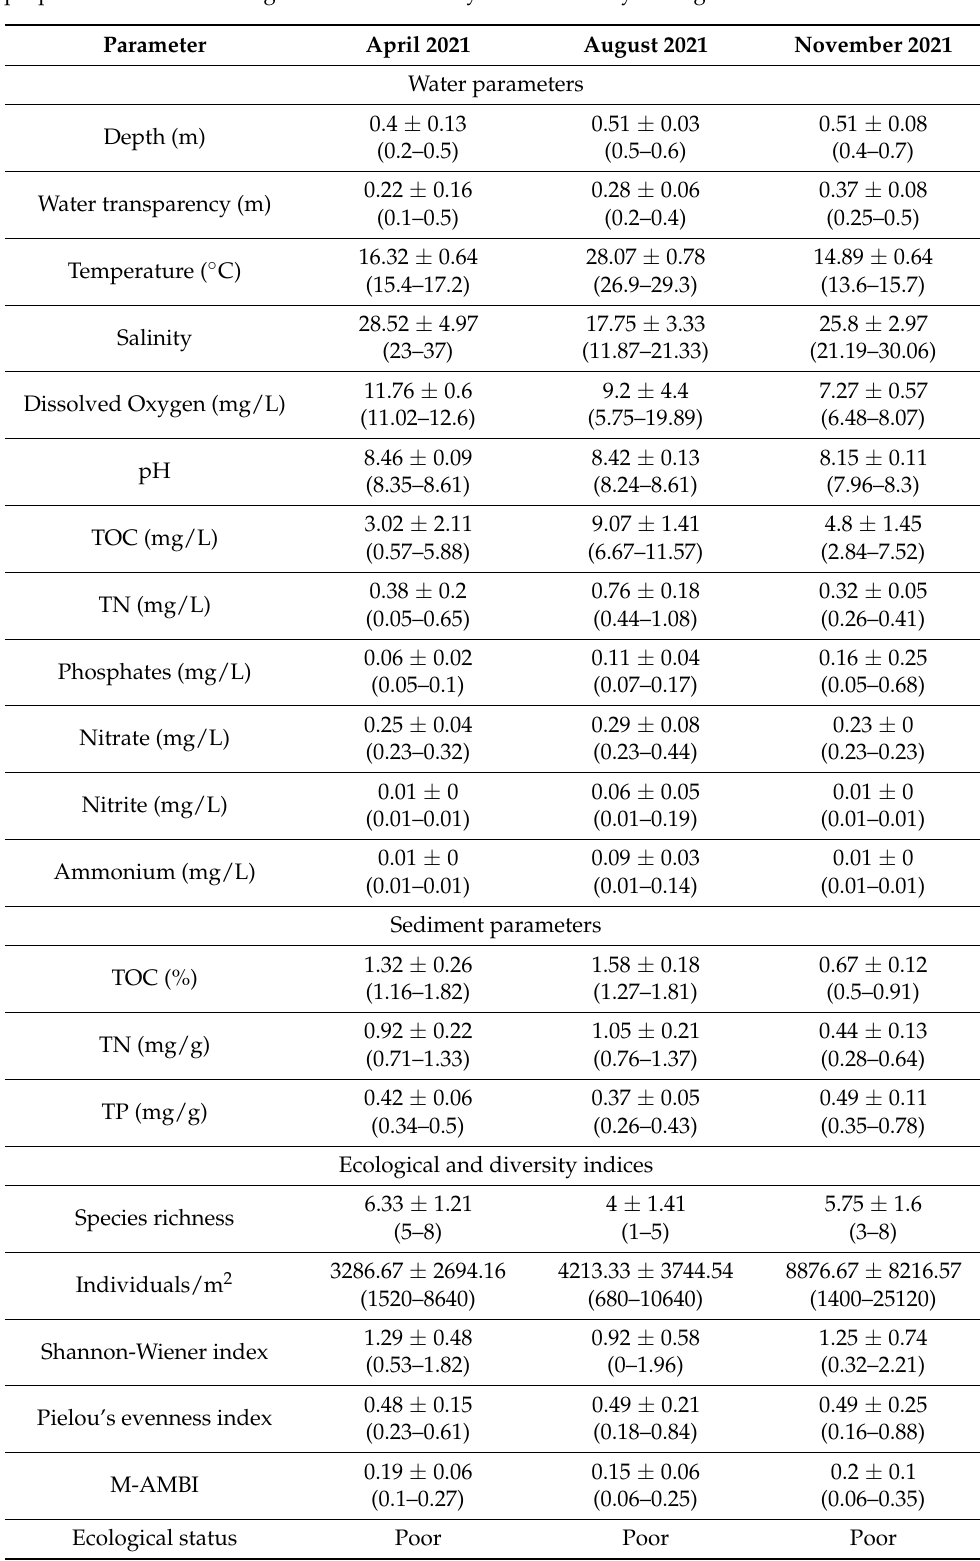
Table 5. Mean ± SD (minimum and maximum values in parenthesis) for water and sediment properties as well as ecological and biodiversity indices in Kotychi